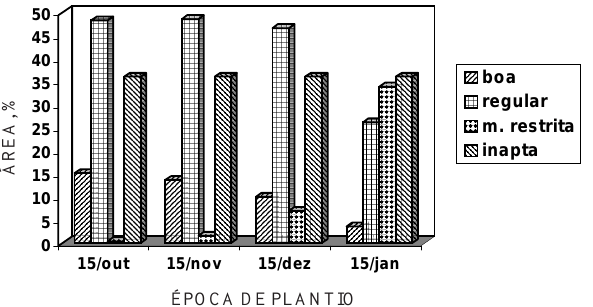
Figura 5. Alteração da aptidão edafoclimática das terras, com o avanço da época de plantio.